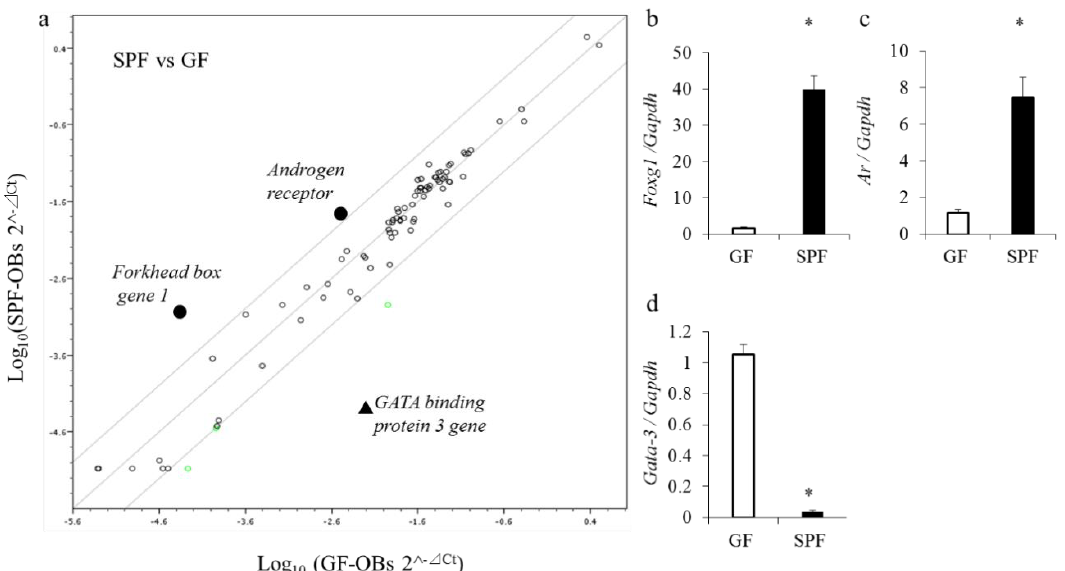
Figure 6. Gene expression profiling in cultured osteoblasts from GF and SPF mice. Calvariae from 8-week-old GF and SPF male mice were harvested, and osteoblasts were isolated and cultured. Total RNA was isolated for gene expression from osteoblasts cultured for 5 weeks. Microarray profiling of transcription gene expression in GF and SPF osteoblasts was performed ( a ). The data from the SPF (ordinate) and GF (abscissa) evaluations are plotted. Constant elevation or variation in levels of gene expression is indicated by black dots or the black triangle, respectively. Circles on the diagonal line represent relative changes in metabolite levels that were stable between the two groups. Black circles denote gene expression that was significantly higher in SPF mice than GF mice (>4 times). The black triangle denotes gene expression that was significantly lower in SPF mice than GF mice (>4 times). On real-time PCR, expression of the forkhead box gene 1 ( Foxg1 ) ( b ) and androgen receptor ( Ar ) ( c ) genes was significantly higher in SPF mice than GF mice. Gata binding protein ( Gata)-3 ( d ) gene expression was significantly lower in SPF mice than GF mice. * p < 0.05, t -test ( n = 4/group).